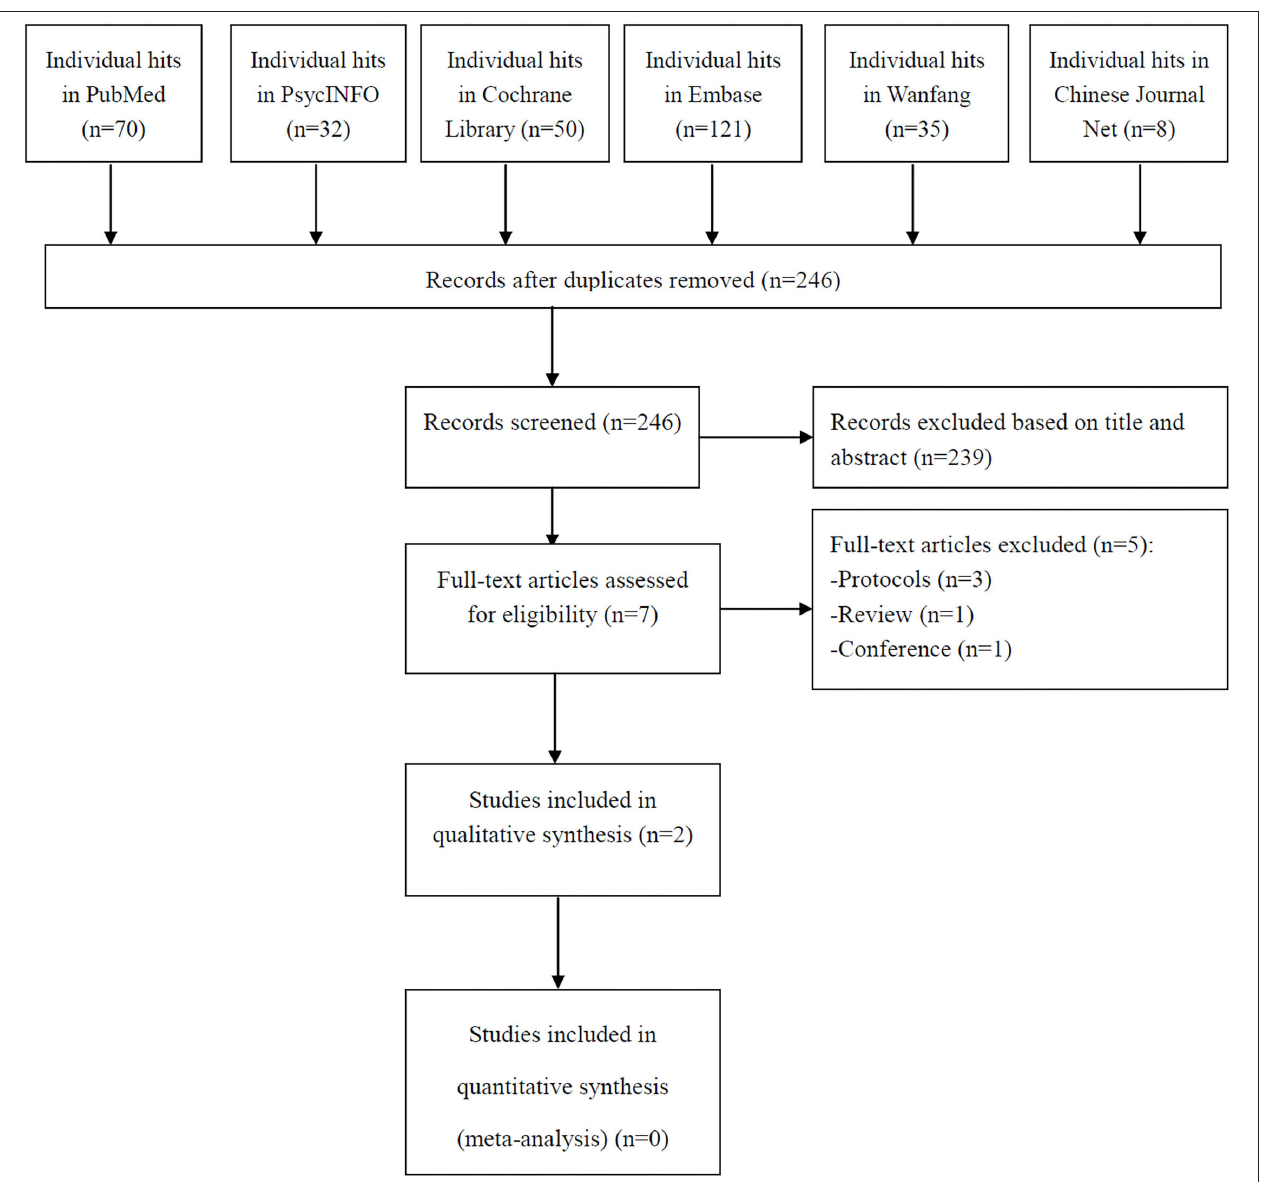
FIGURE 1 | PRISMA flow